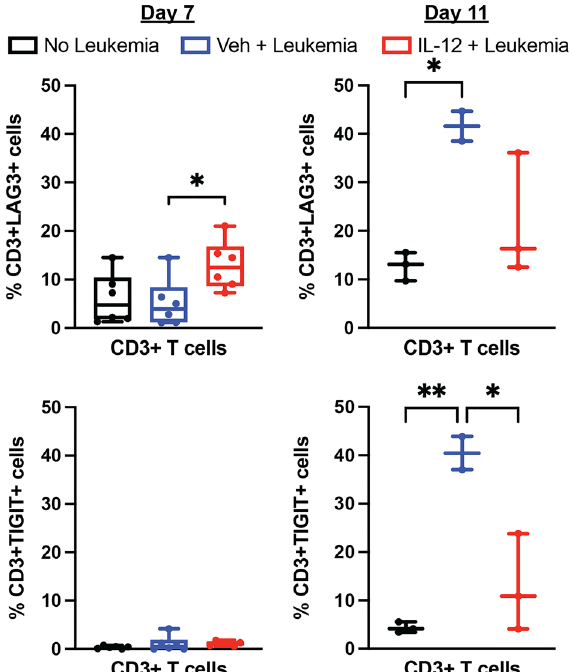
Figure 6. IL-12 abrogates leukemia-induced increases in cell surface expression of LAG3 and TIGIT on T-cells. Bone marrow cells were harvested from mice as in Fig. 3 on day 7 (left; n = 6/group) and day 11 (right; n = 3/group) for flow cytometry. The percentage of LAG3 + (top) and TIGIT + (bottom) T-cells is demonstrated. (* P < 0.05, ** P < 0.01; ANOVA with Tukey multiple comparisons test).